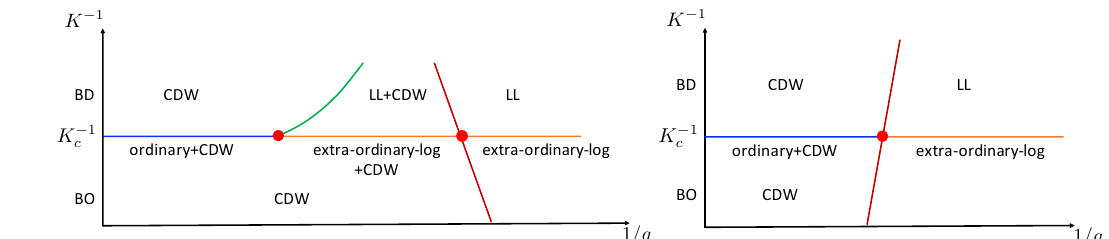
Figure 8: Possible phase diagrams for the 2 + 1D Bose-Hubbard model with integer bulk filling and a density ρ = 1 / 2 on the boundary. All phase labels refer to boundary behavior. While the phase diagram on the left is certainly possible, it is not clear if the one on the right can be realized with a direct continuous transition as a function of g at K = K c